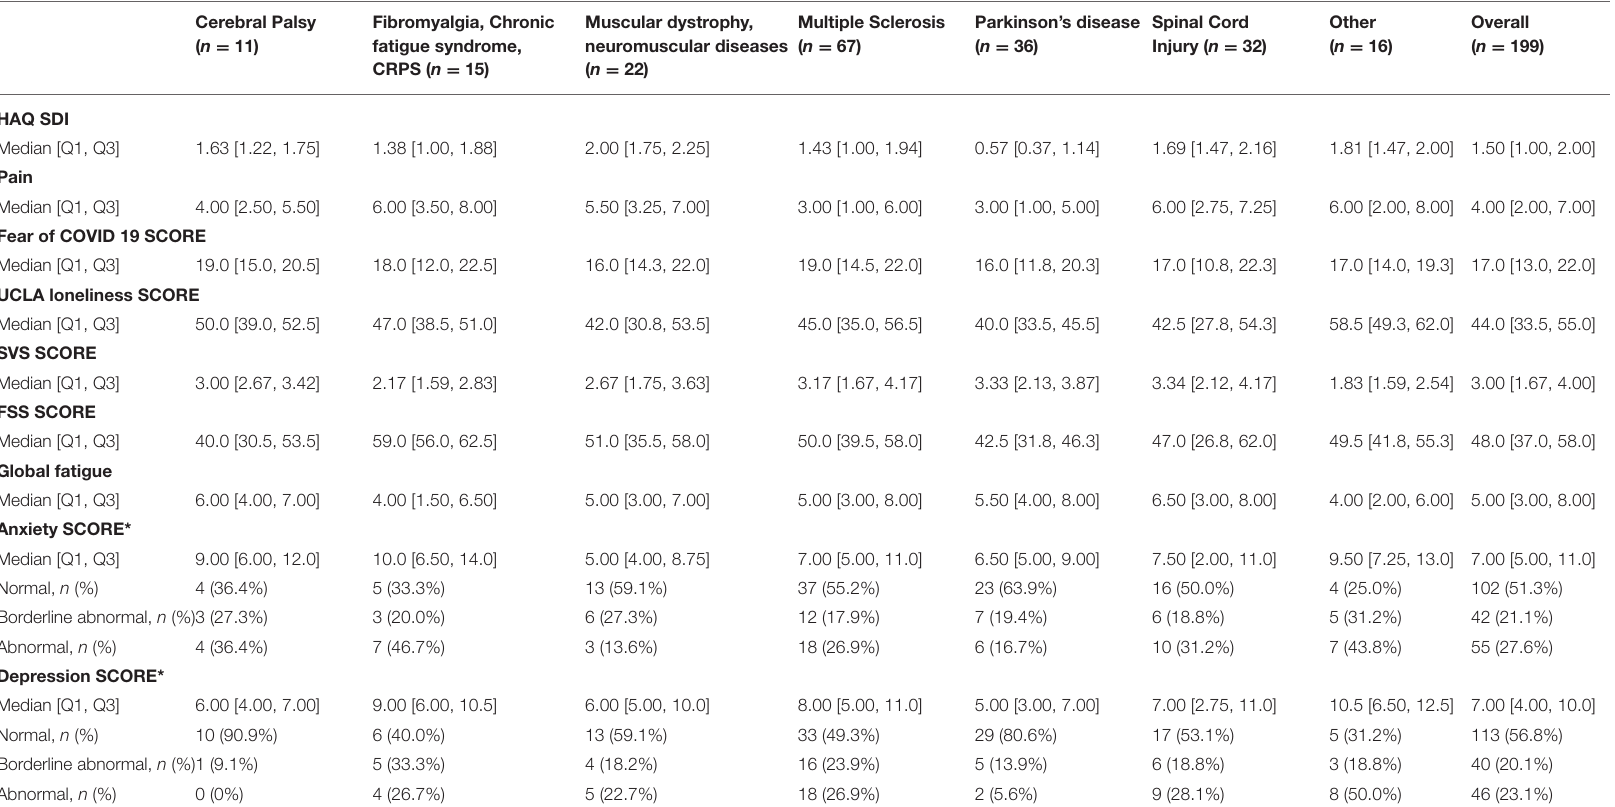
TABLE 2 | Summary of outcomes stratified by neurological